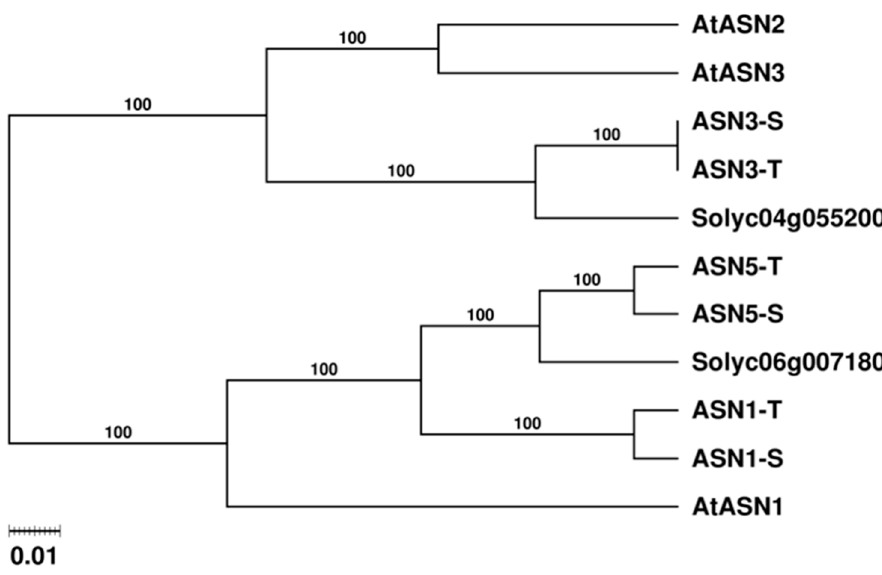
Figure 2. Molecular phylogenetic tree of plant asparagine synthetases (ASN). The ASN genes of Nicotiana tabacum originate from ancestors of Nicotiana sylvestris (S) or Nicotiana tomentosiformis (T). Tobacco polypeptides ASN1-S, ASN1-T, ASN3-S, ASN3-T, ASN5-S, and ASN5-T were compared with Arabidopsis proteins AtASN1 (At3g47340), AtASN2 (At5g65010), and AtASN3 (At5g10240) and tomato proteins Solyc06g007180 and Solyc04g055200. The tree was constructed by using the PHYLIP software, and the numbers are bootstrap values. The scale indicates the distance between two sequences, based on the distance matrix from MUSCLE alignment.